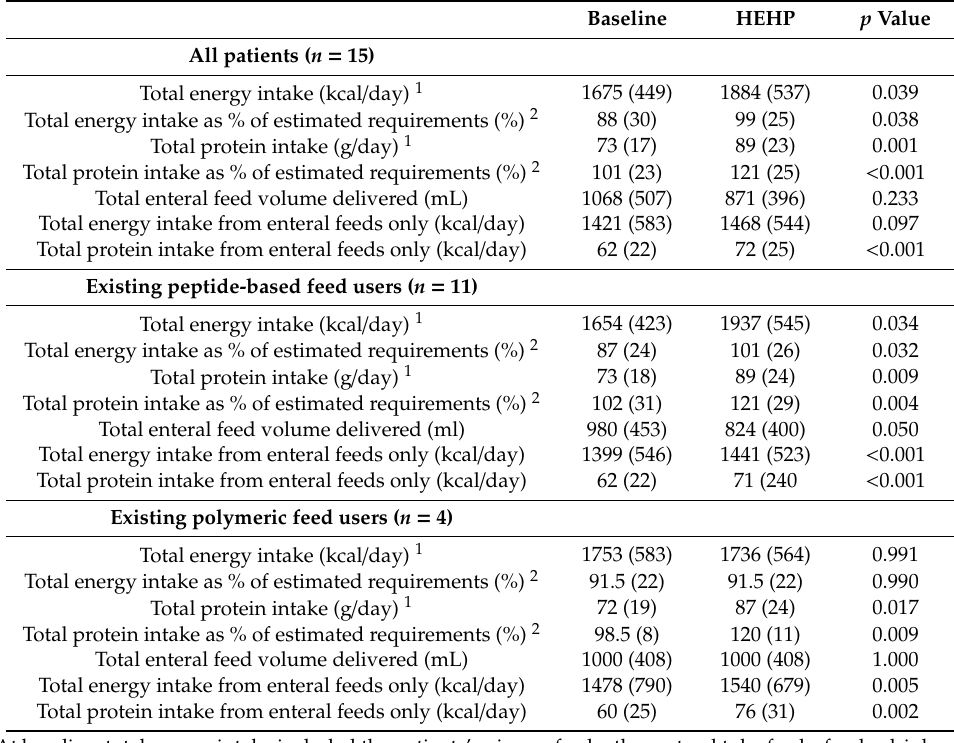
Table 4. Mean (SD) total energy and protein intake, percentage of estimated requirements and delivered amounts of enteral feeding at baseline and end of intervention